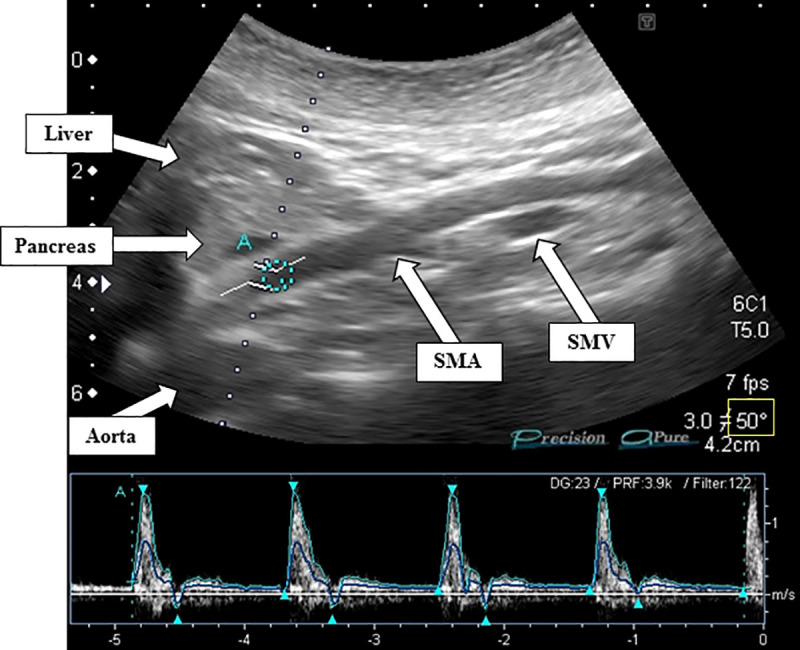
Measurement of SMA blood flow by DUS.Blood flow velocity was measured 3 cm from the origin of the SMA by pulsed DUS. The waves highlighted in light blue show four cardiac cycles (bottom).